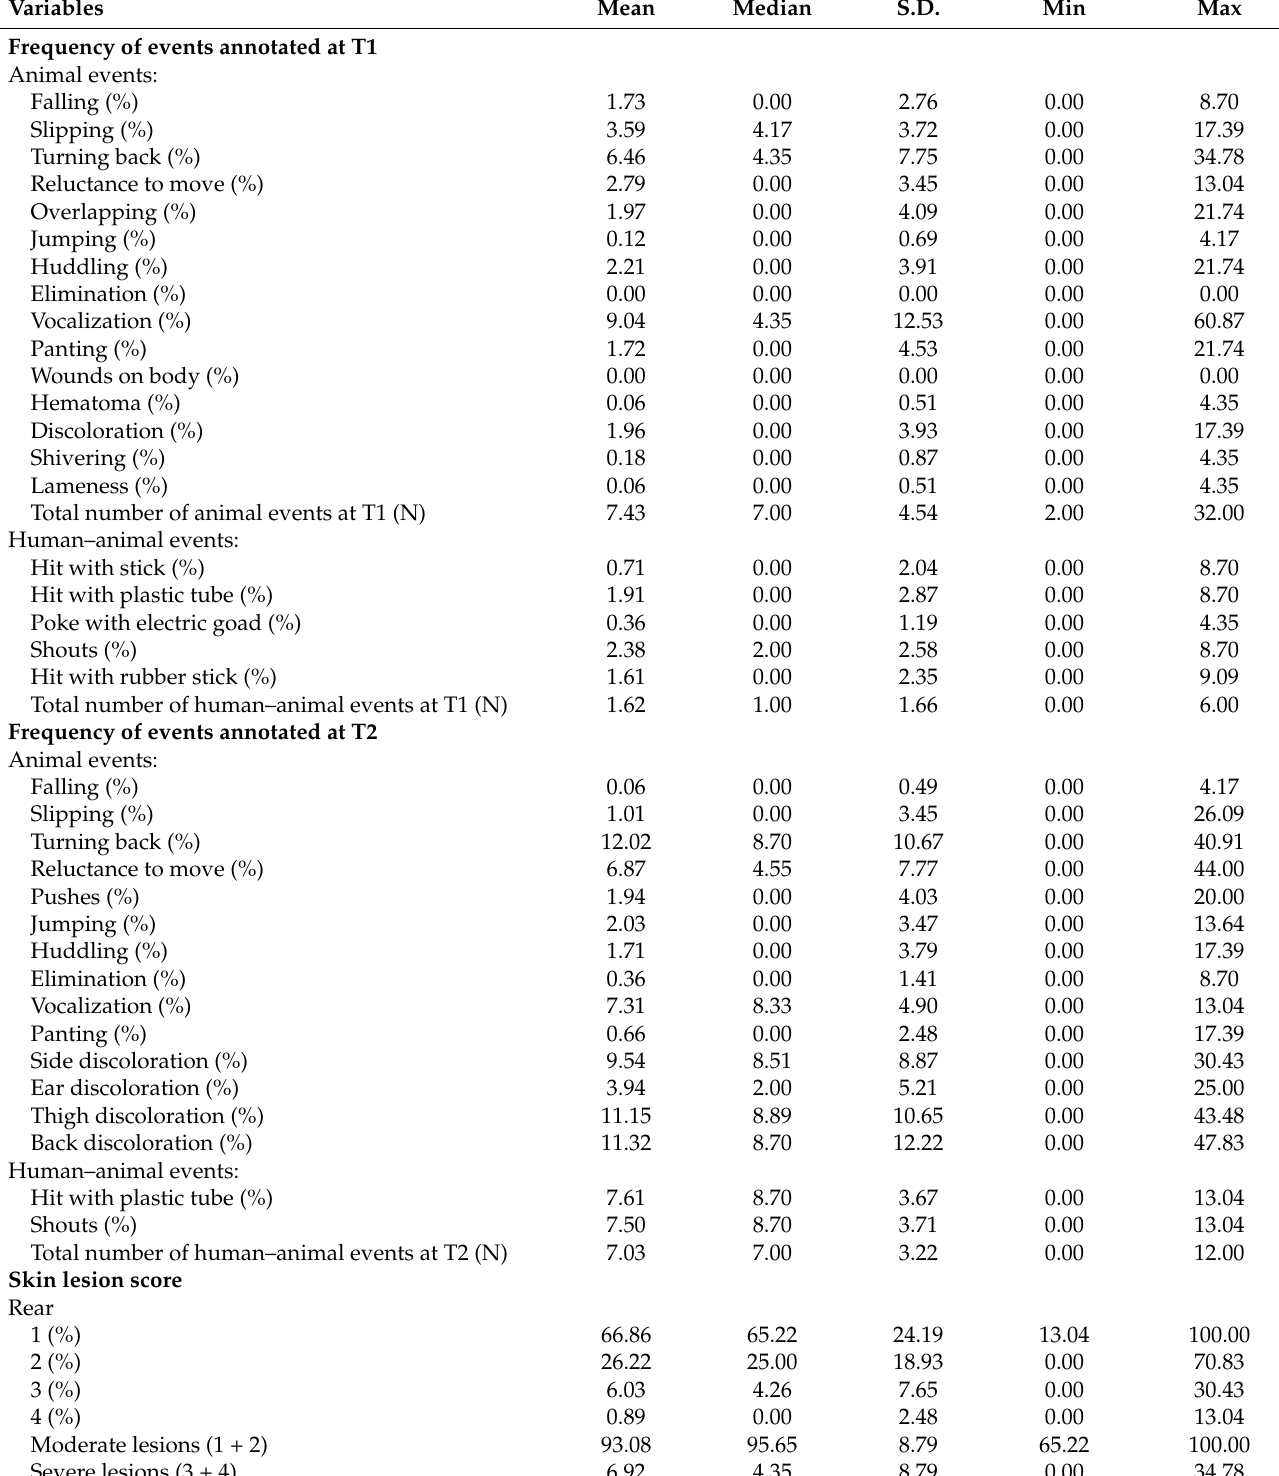
Table 2. Descriptive statistics (mean, median, standard deviation, minimum and maximum) for the frequency of animal and human–animal events annotated at unloading (T1) the frequency of animal and human–animal events annotated from the lairage pen door to the entrance of the stunning area (T2), and for the prevalence of carcass skin